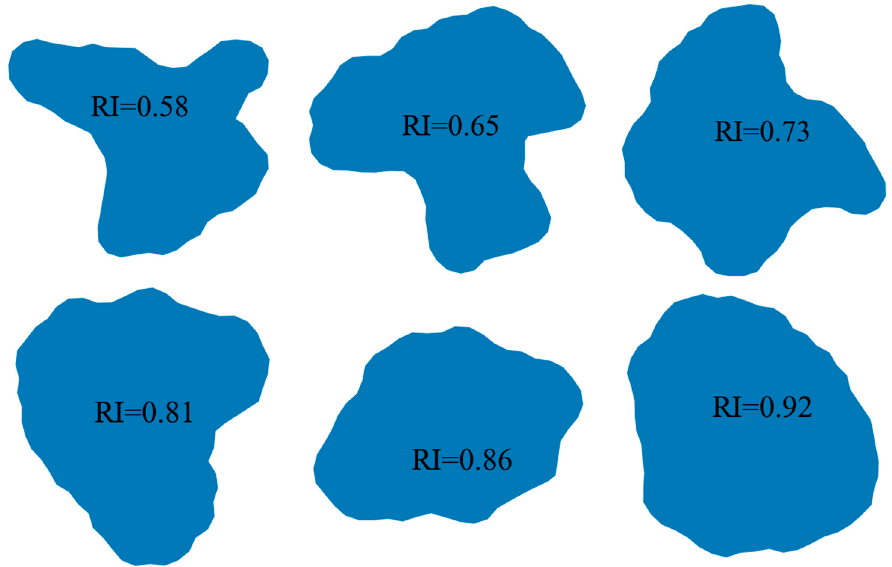
Figure 6. Particles with different roundness.